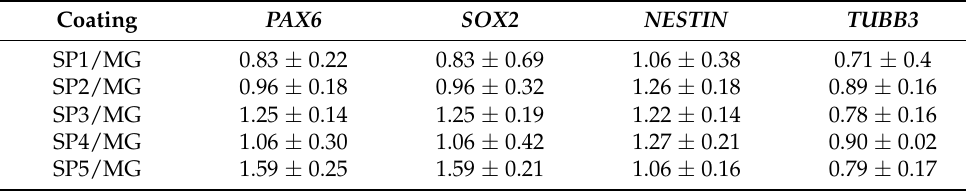
Table 1. Effect of NPC cultivation on CCs on the expression of the neuron-specific gene.